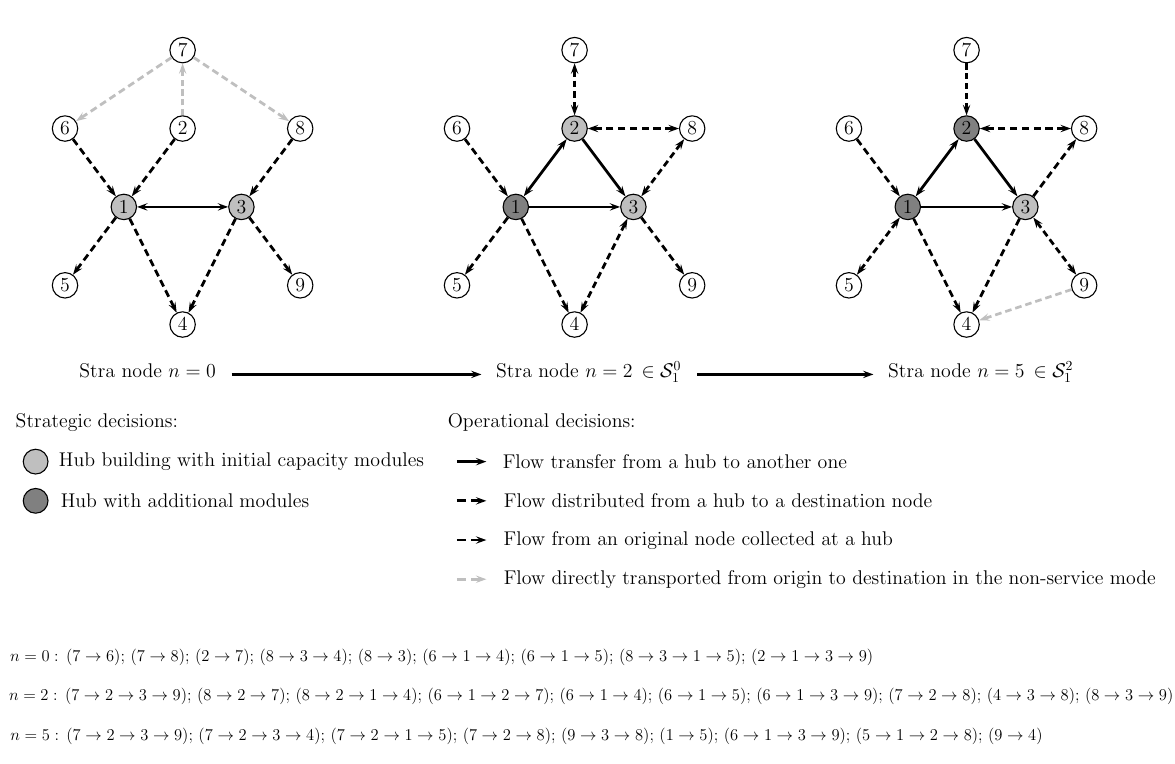
Figure A1. Origin and destination network nodes and hubs representation. Strategic and operational